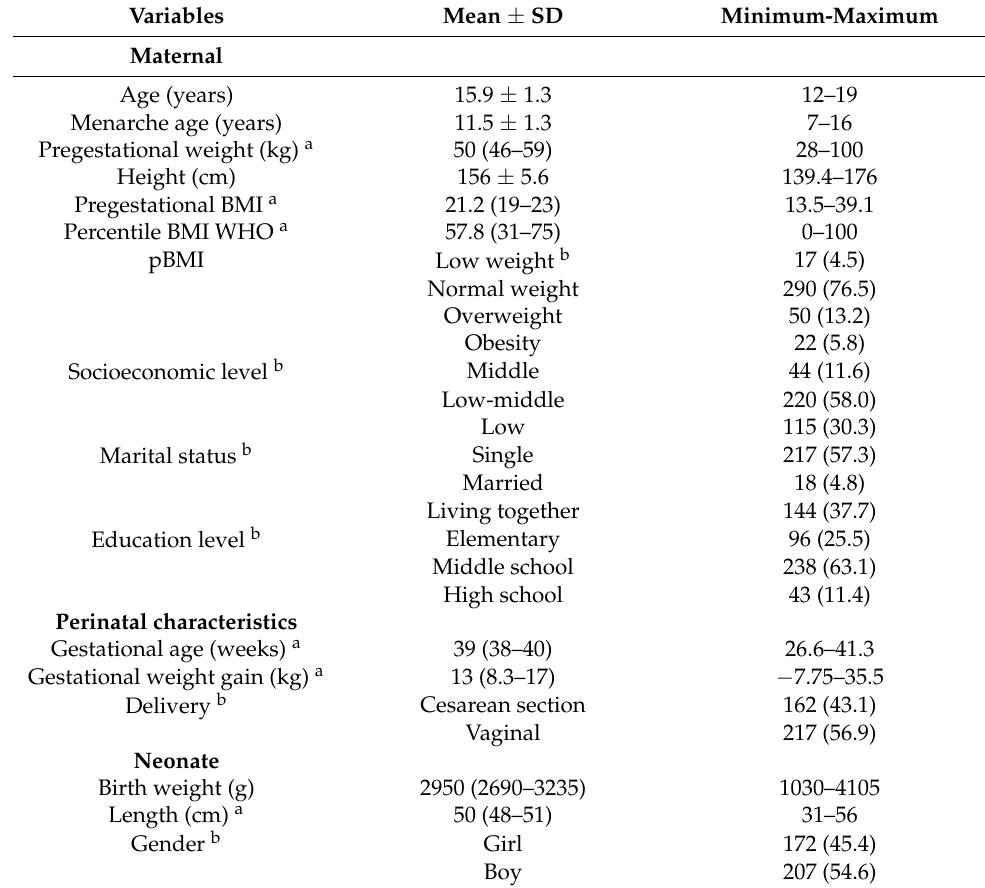
Table 2. Characteristics of pregnant adolescents and their offspring ( n =